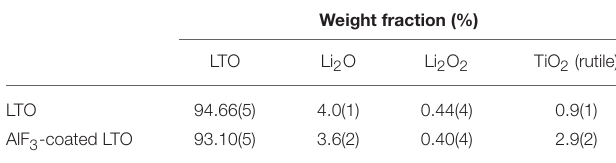
TABLE 2 | Phase composition of LTO and AlF 3 -coated LTO samples (AlF 3